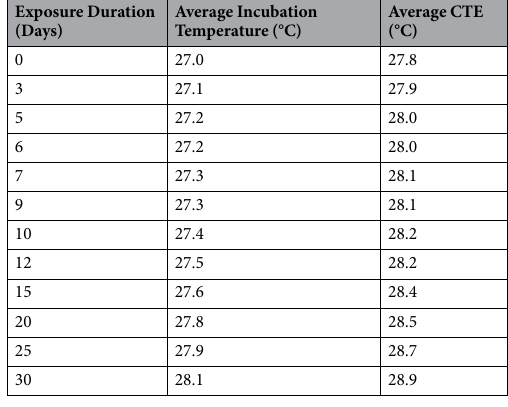
Table 1. Incubation treatments.